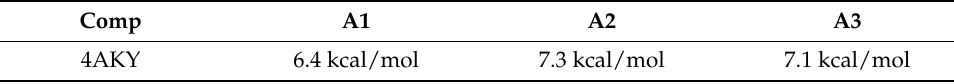
Table 2. The binding free